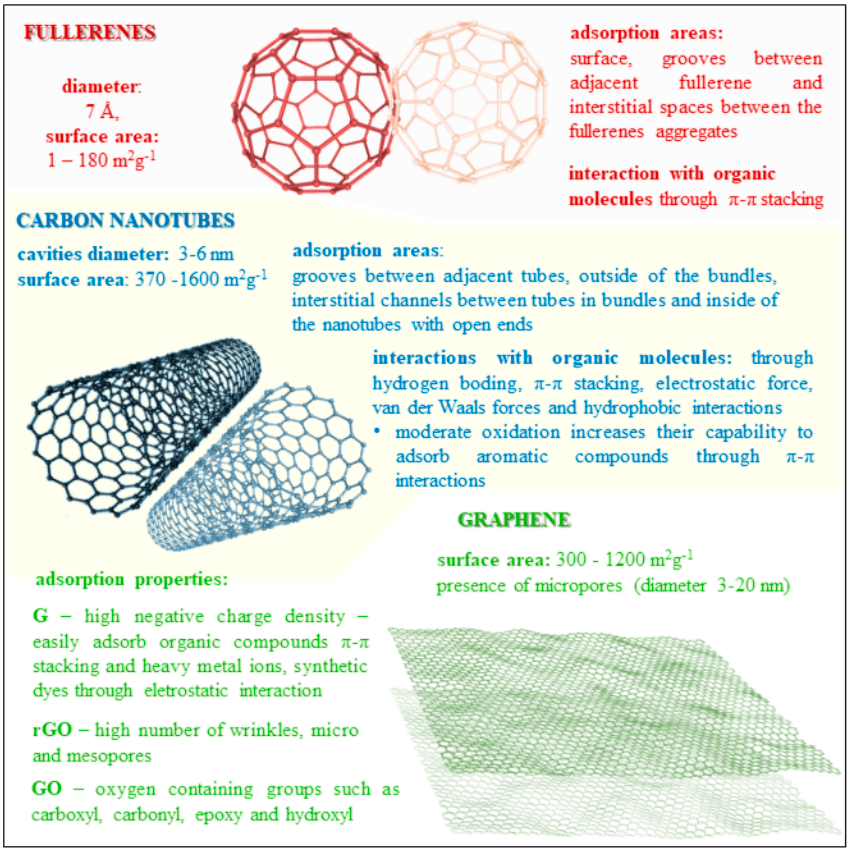
Figure 2. Key properties of carbon nanoparticles such as fullerenes, carbon nanotubes, and graphene (native graphene (G), reduced graphene (rGO), and graphene oxide (GO)). Mycotoxins can be bound to the surface, bundles, grooves, or channels between nanoparticles via different binding interactions.